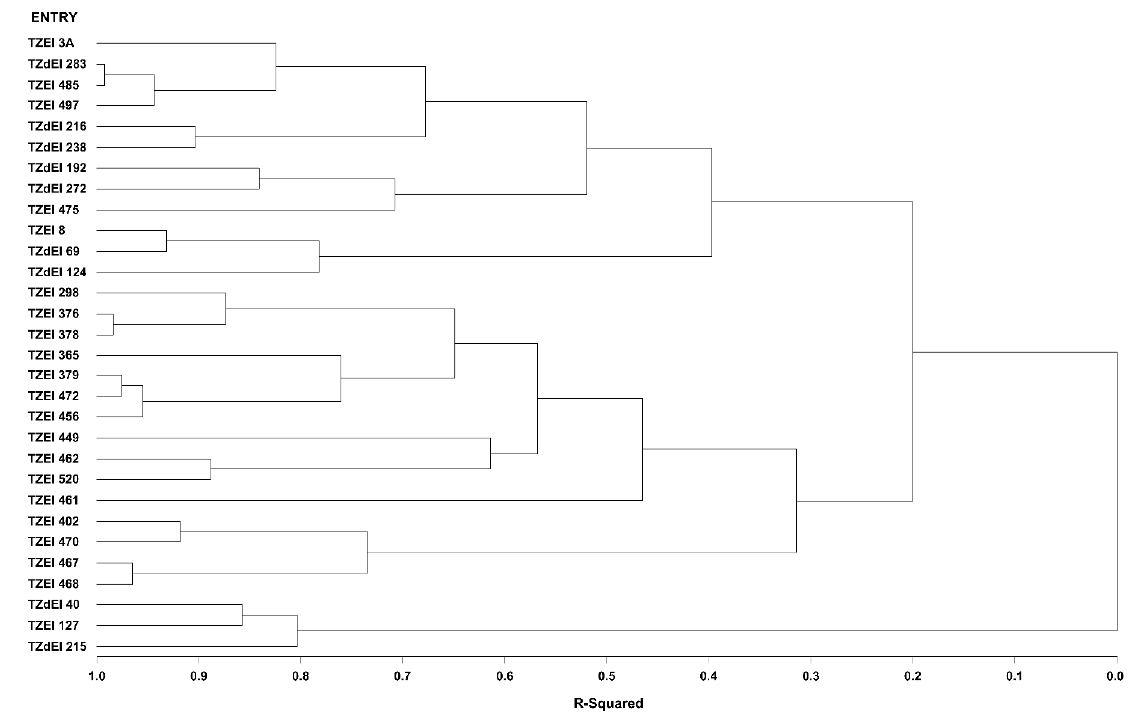
Figure 2. Dendrogram of thirty early maturing maize inbred lines obtained using Ward’s minimum variance cluster analysis based on the HGCAMT method across four optimal environments, 2016–2017.